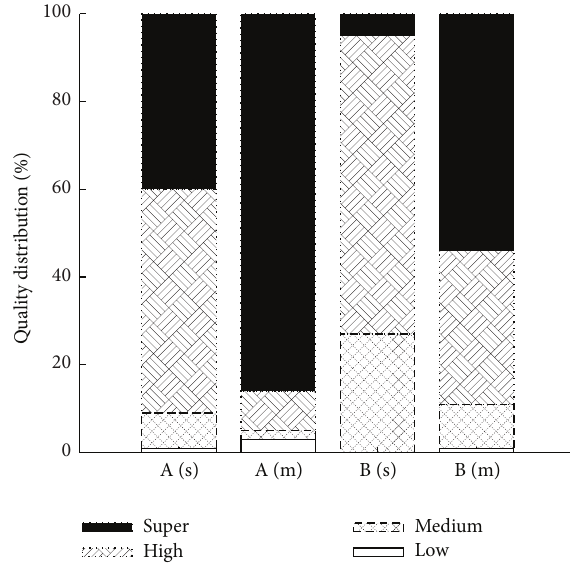
Figure 16: Quality distribution for different types of streaming in real-world networks. A: on-demand streaming, B: live streaming; (s) is single link; (m) is multilink.